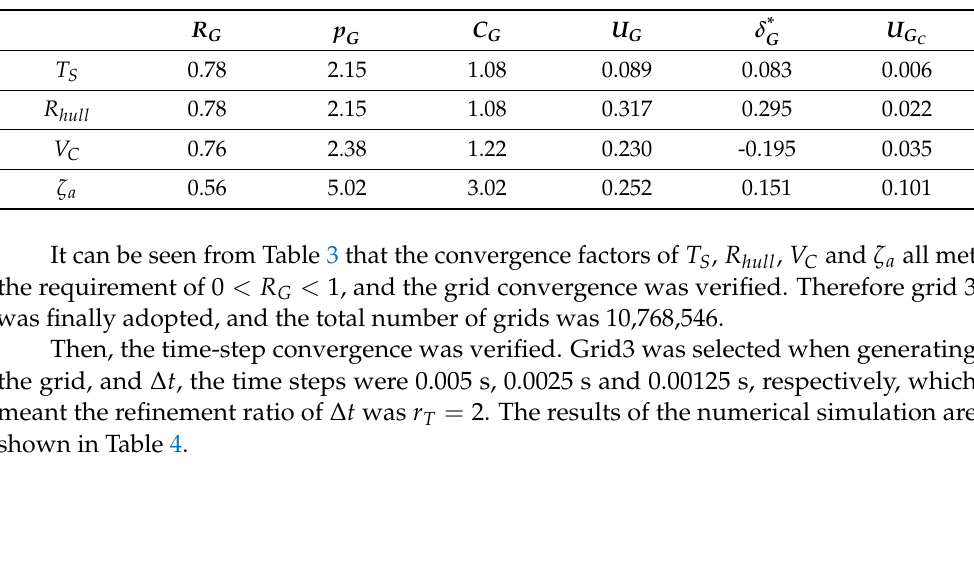
Table 3. Grid convergence